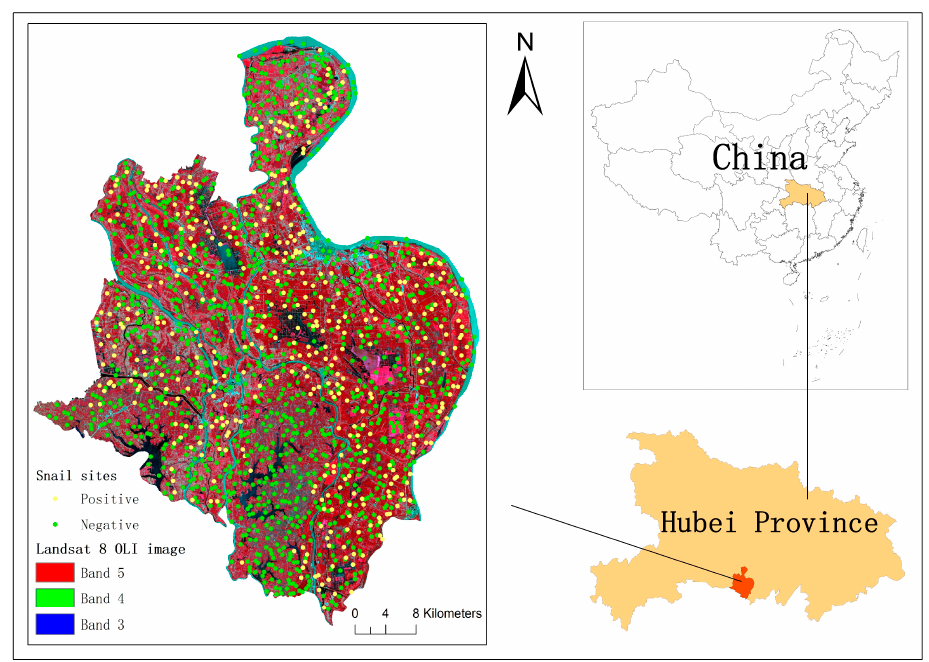
Figure 1. The location of Gongan County and the distribution of snail sample sites overlaid on a satellite image.